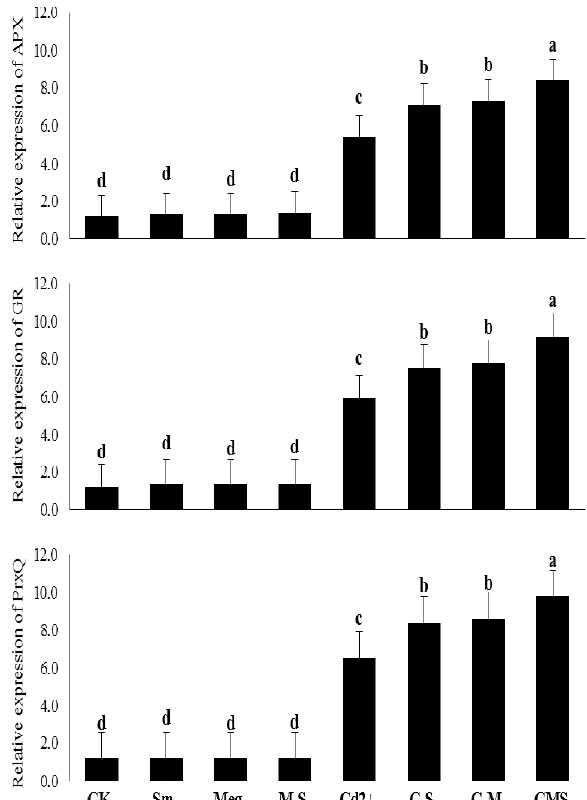
Figure 5. Response of antioxidant enzyme-encoding gene transcript levels (transcriptional levels were quantified by qPCR relative to actin transcriptional level, qPCR data represent the average from three independent experiments with two technical replicates each) of maize plants to foliar application of silymarin (Sm), maize grain extract (MEg), or silymarin-enriched maize grain extract (MEg-Sm) under Cd stress. The same letters on the bars (mean ± SE) of the parameters indicate nonsignificant differences, whereas the significant differences are a result of different letters according to the least significant difference (LSD) test ( P ≤ 0.05). CK = control, Sm = silymarin, Meg = maize grain extract, M-S = silymarin-enriched maize grain extract, C-S = Cd+Sm, C-M = Cd+Meg, CMS = Cd+Meg+Sm.